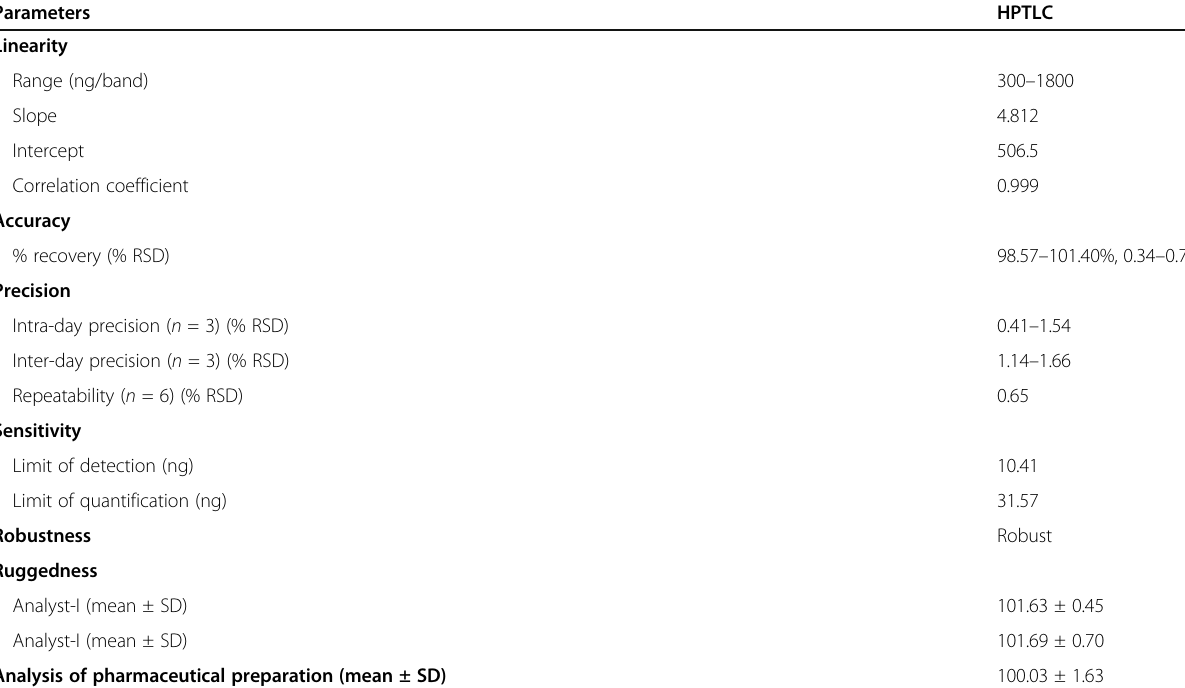
Table 7 Summary of linear regression data and validation parameters of HPTLC method